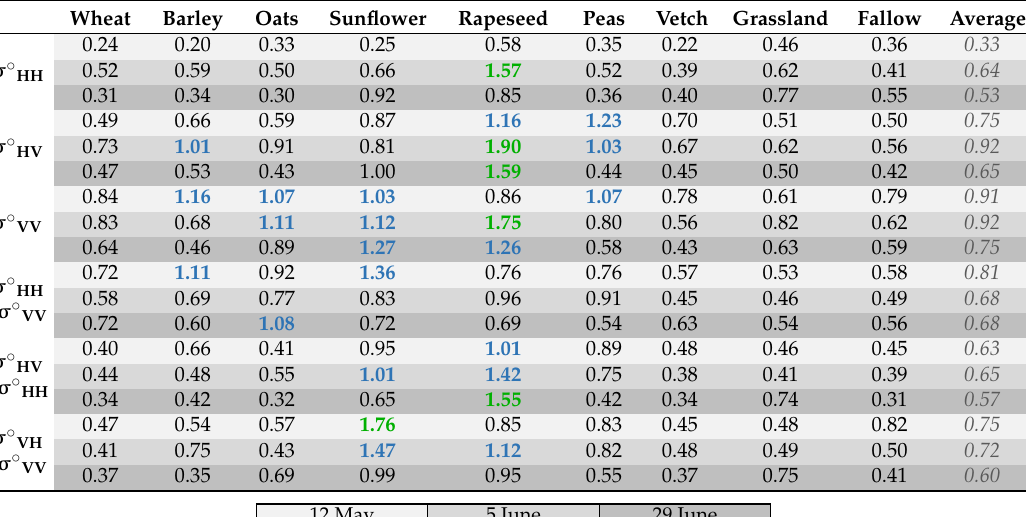
Table 1. Average JM distance for each crop and date, as well as the average of all crop pairs, for σ ˝ σ ˝ σ ˝ HH , HV , VV, and their ratios. Colors represent values above 1.00 (blue) and above 1.50 (green), and shades represent the different dates